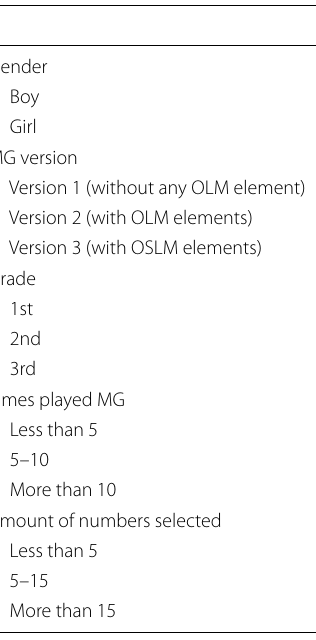
Table 1 Demographic profile of 137 respondents